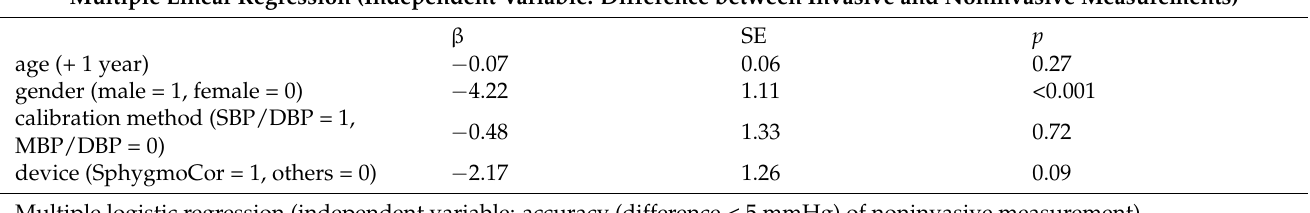
Table 4. Multiple regression analyses between measurement accuracy and potential impacting